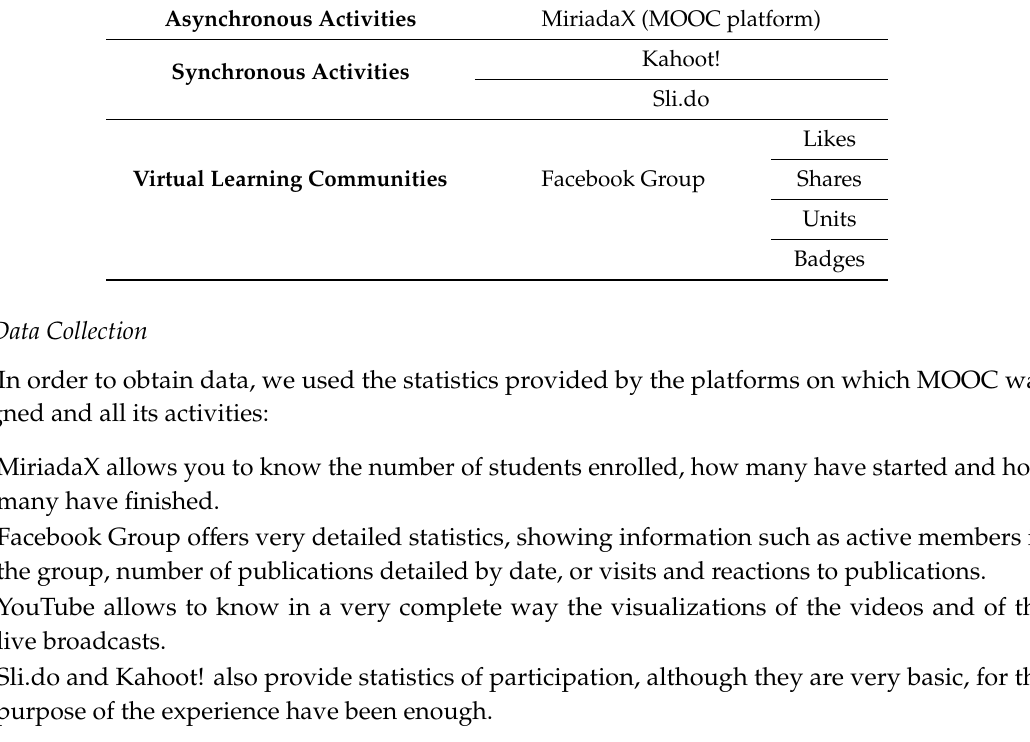
Table 1. Relationship between gamification activities and technologies used.